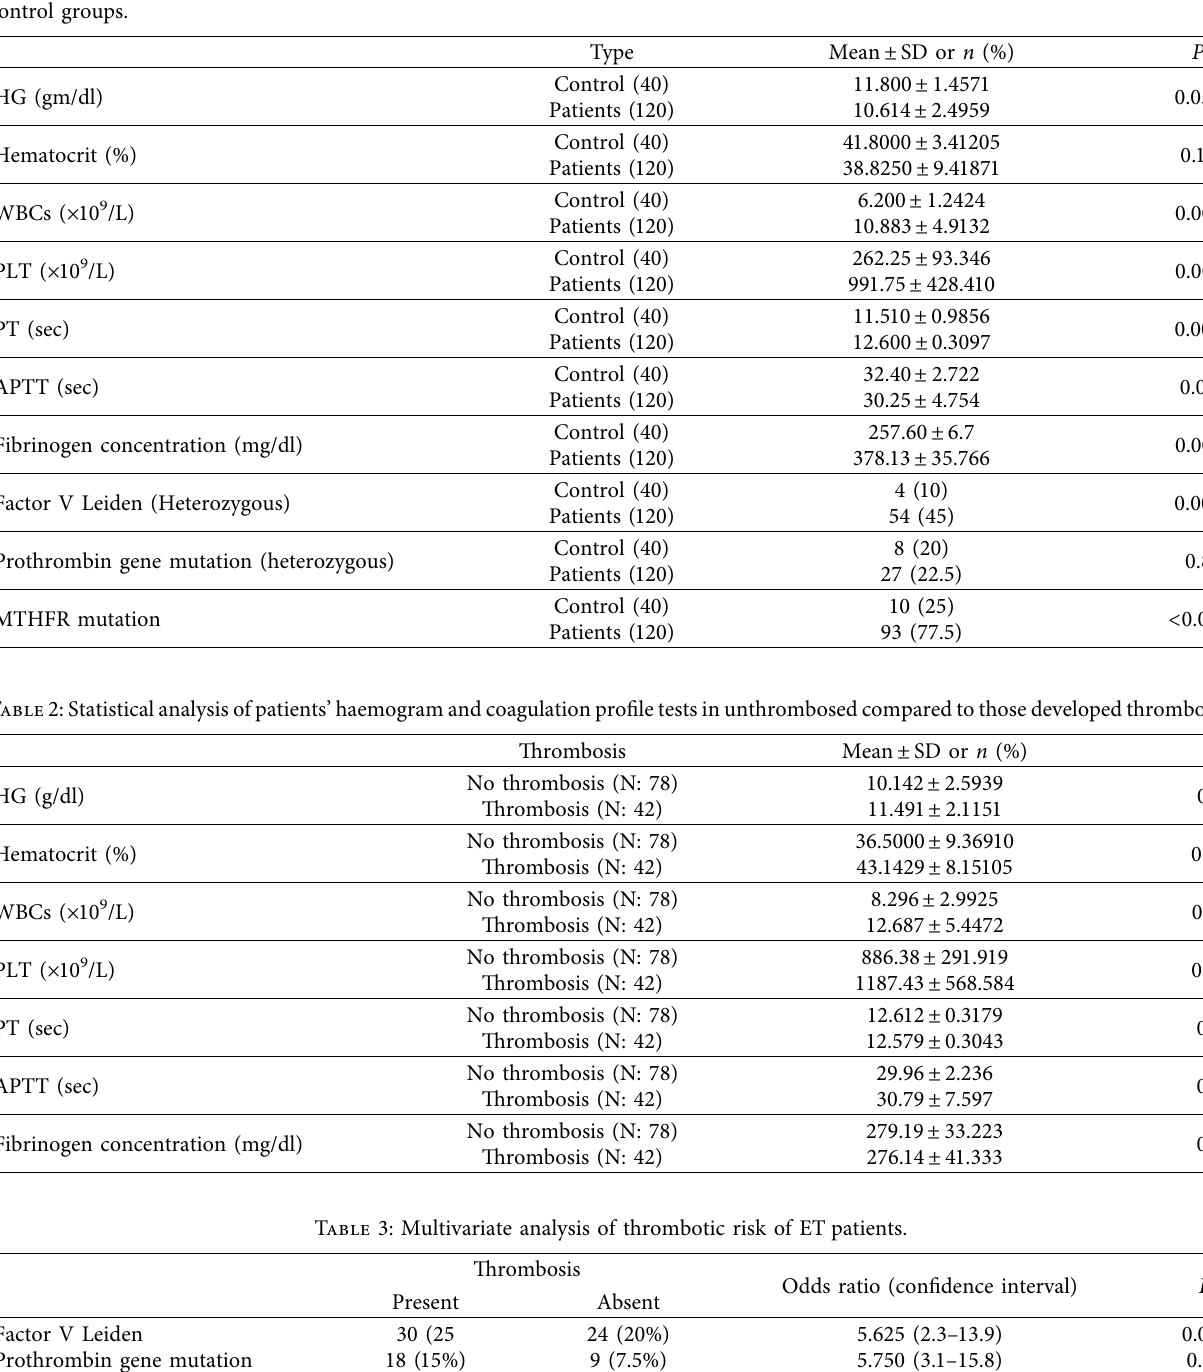
Table 1: Statistical analysis of haemogram, coagulation profile tests, and thrombophilia gene in essential thrombocythemia patients versus control groups.